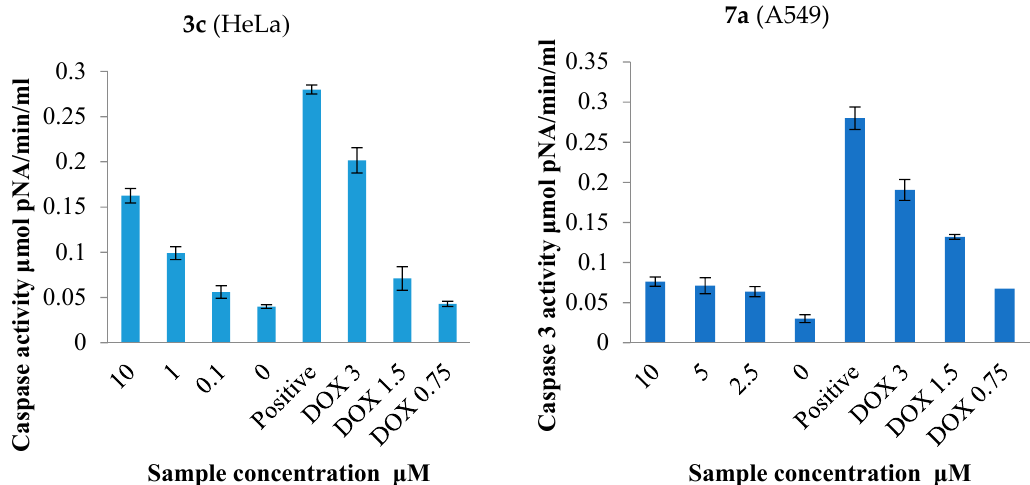
Figure 4. Effects of compound 3c and 7a on caspase-3 activity in HeLa and A549 cell lines compared to the negative control (untreated cells) and doxorubicin hydrochloride.